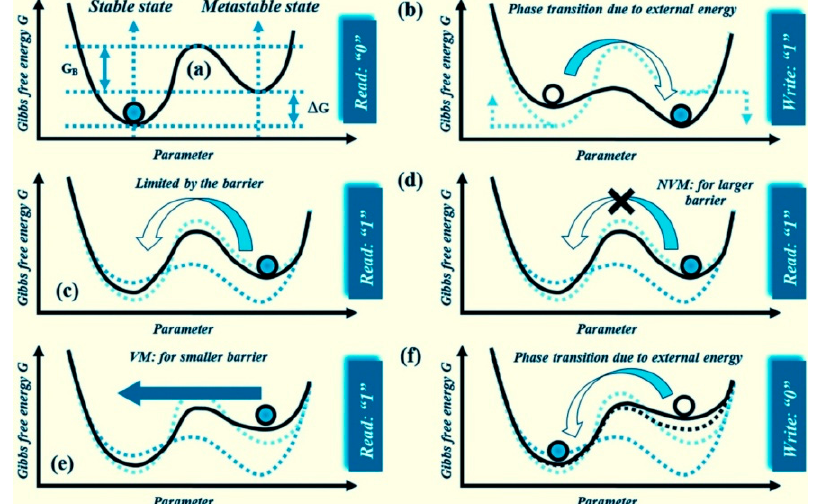
Figure 5. ( a ) Illustration of Gibbs free energy variation of stable phase (state “0”) and metastable phase (state “1”) of a typical Mott memory under writing and reading operations. Stable phase is at the equilibrium system at constant temperature, where ∆ G is the free energy di ff erence between state “0” and state “1”. ( b ) The external energy driven phase transition from state “0” to state “1”. ( c ) In state “1”, after the writing signal removal an energy barrier (G B ) will be faced by the system. ( d ) Before the transition from “1” to “0”, the system will behave as NVM if the energy barrier is large. ( e ) If the energy barrier is small, the system can behave like VM. ( f ) For the transition from “1” to “0”, another external signal is